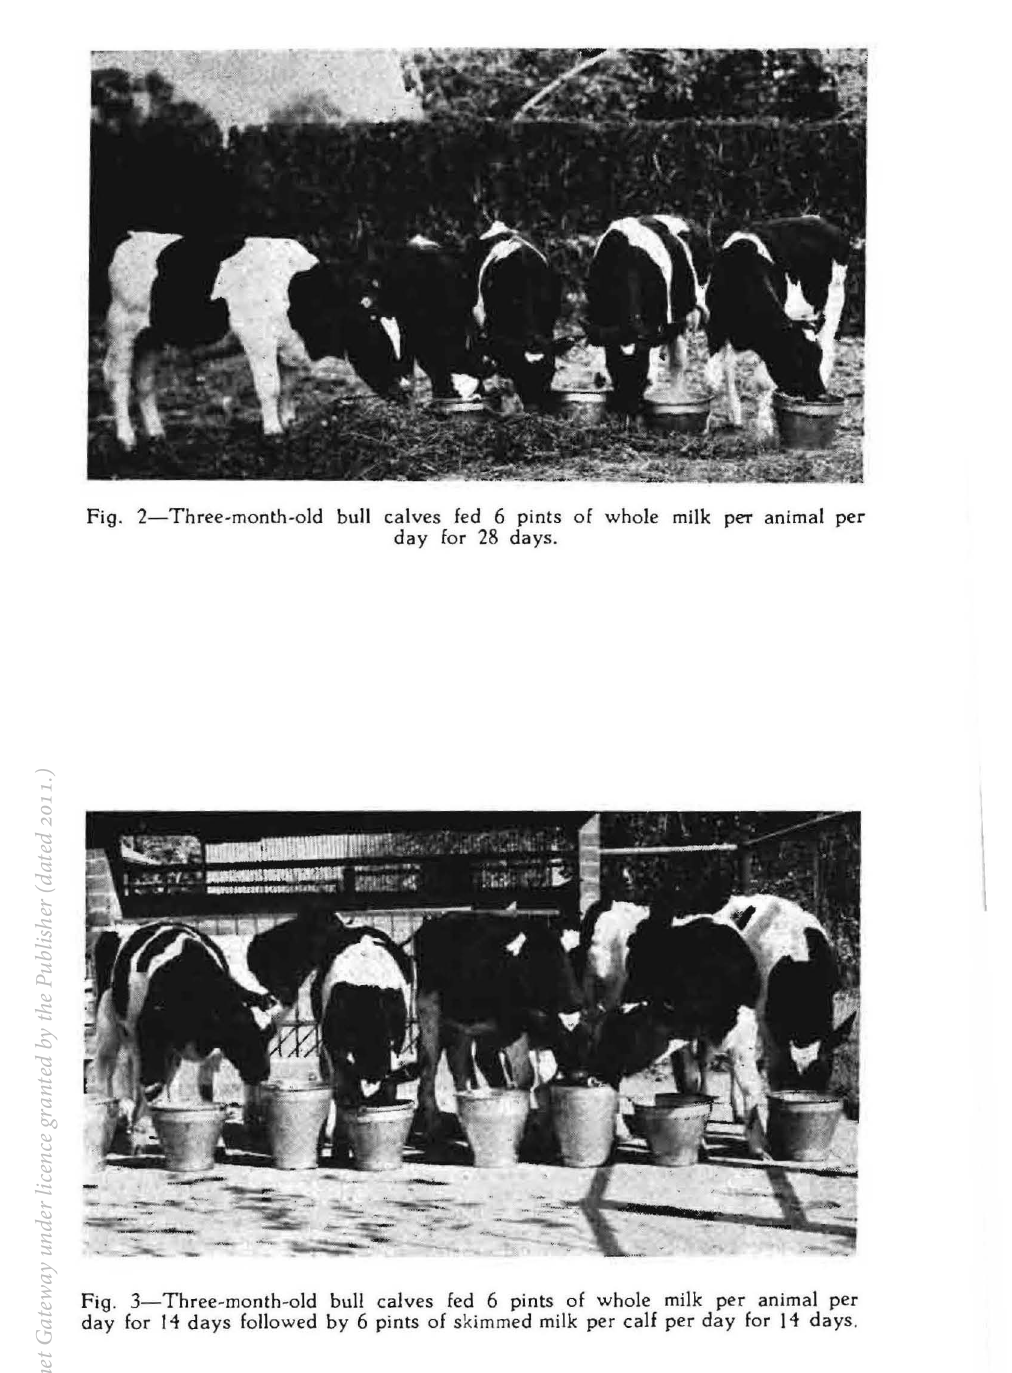
Fig. 3- Three-month-old bull calves fed 6 pints of whole milk per animal per day for 14 days followed by 6 pints of skimmed milk per calf per day for 14 days.